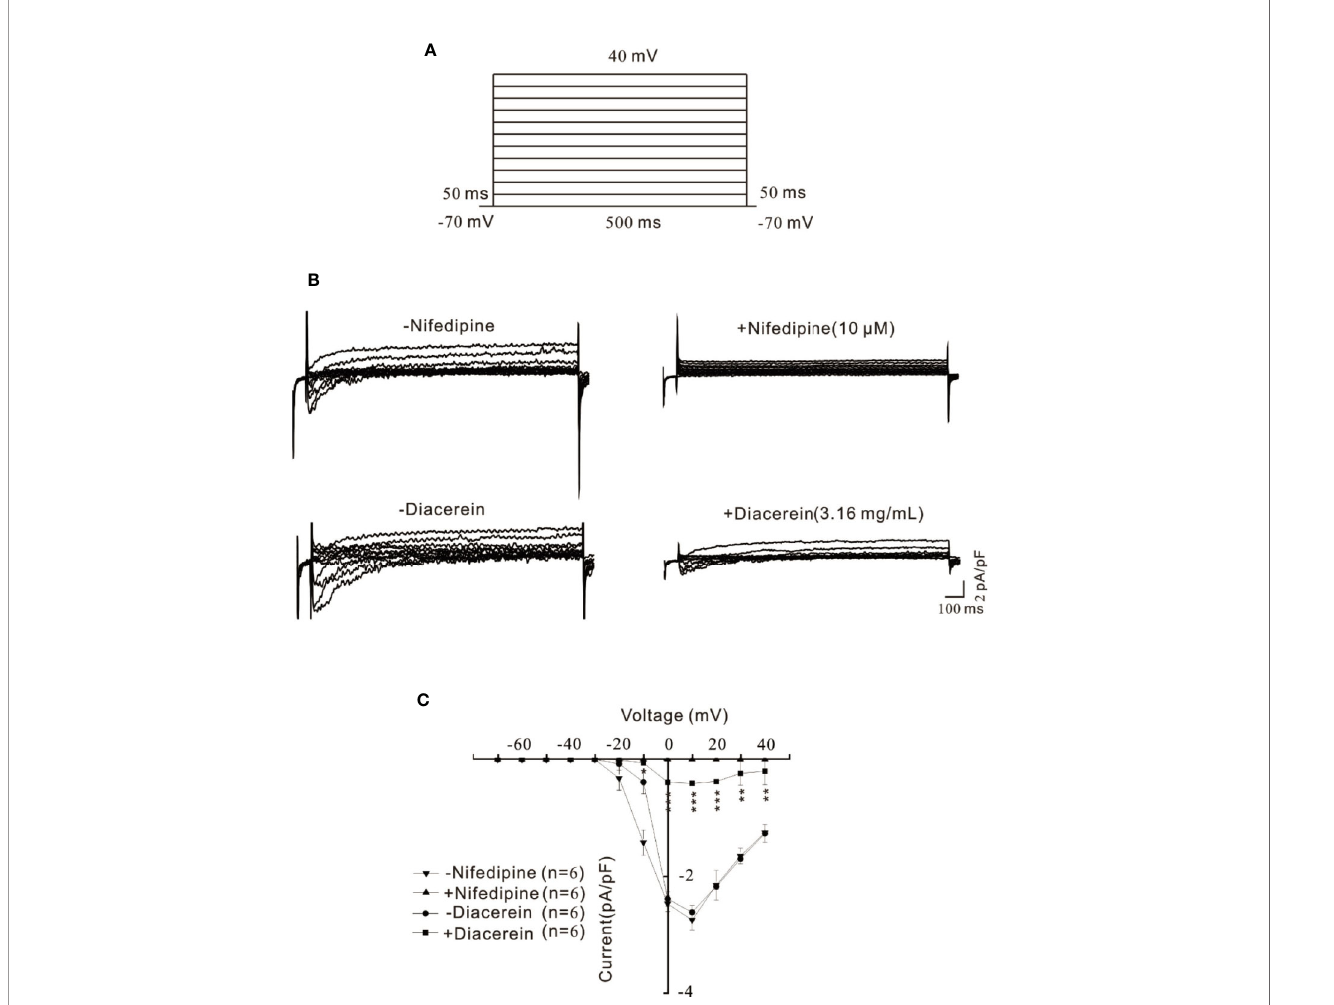
FIGURE 3 | Diacerein blocked voltage-dependent L-type Ca 2+ channel (VDLCC) currents on single mouse airway smooth muscle cell (mASMC). (A) The protocol used to measure VDLCC-mediated currents. (B) VDLCC currents could be abolished by 10 m M nifedipine or 3.16 mg/ml diacerein. (C) Current-voltage curve was constructed based on the results of six cells from six mice. NS, no signi fi cant, *, p < 0.05, **, p < 0.01, ***, p <